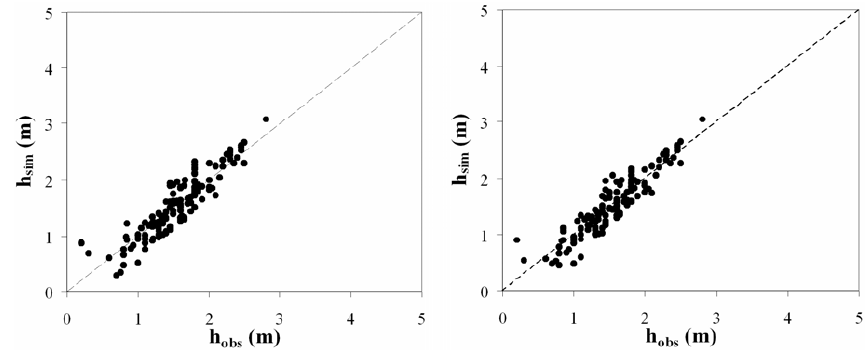
Fig. 9. Dotty plots related to the calibrations with 143 data points and calibration strategies C (left) and F